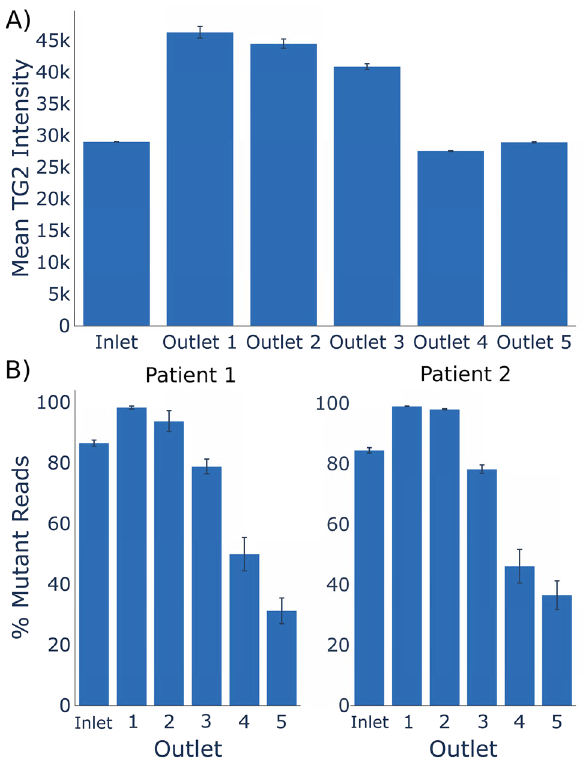
Figure 6. Sorting of primary ascites samples. To assess the usefulness of our platform in a clinical setting, we used our device to sort metastatic cells from patient ascites samples. Enrichment of putative cancer cells (TP53 mutant, high TG2 intensity) was achieved in outlet 1 and 2 for ( A ) one patient as quantified via immunocytology and ( B ) two separate patients as quantified via